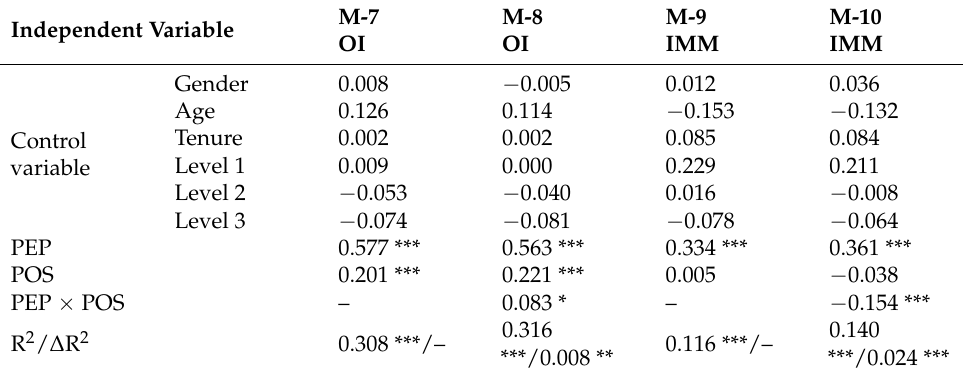
Table 6. The moderating effect of perceived organizational